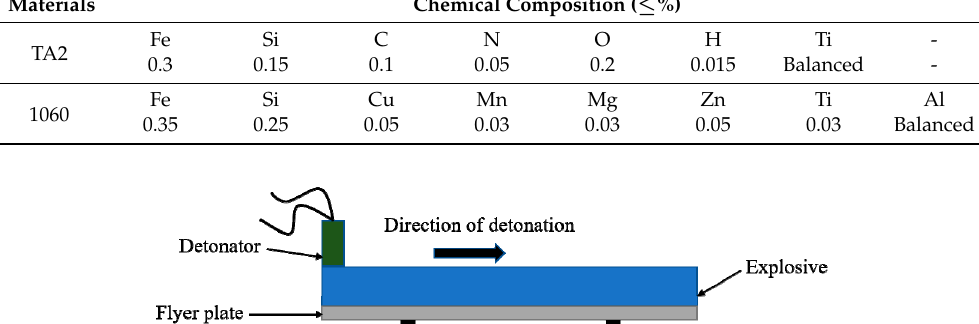
Table 1. Chemical composition of experimental materials (wt%).